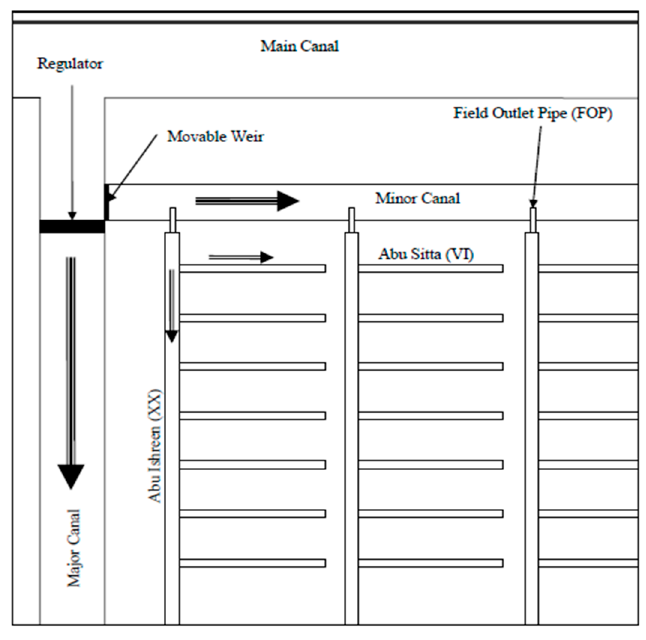
Figure 2. Field irrigation system in Gezira scheme.